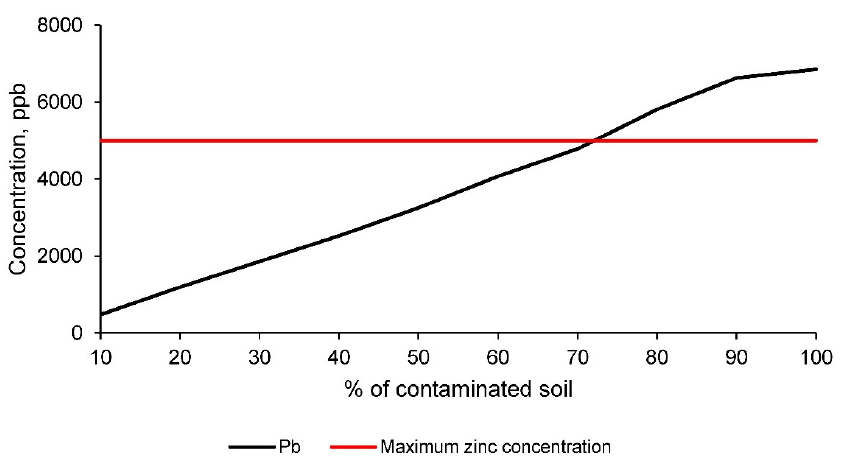
Figure 11. Zinc concentration in the leachate, obtained according to the TCLP leaching test [1], for the different families of ceramics, conformed with clay and the contaminated soil, compared to the maximum permissible limit established by the EPA for domestic water [40].